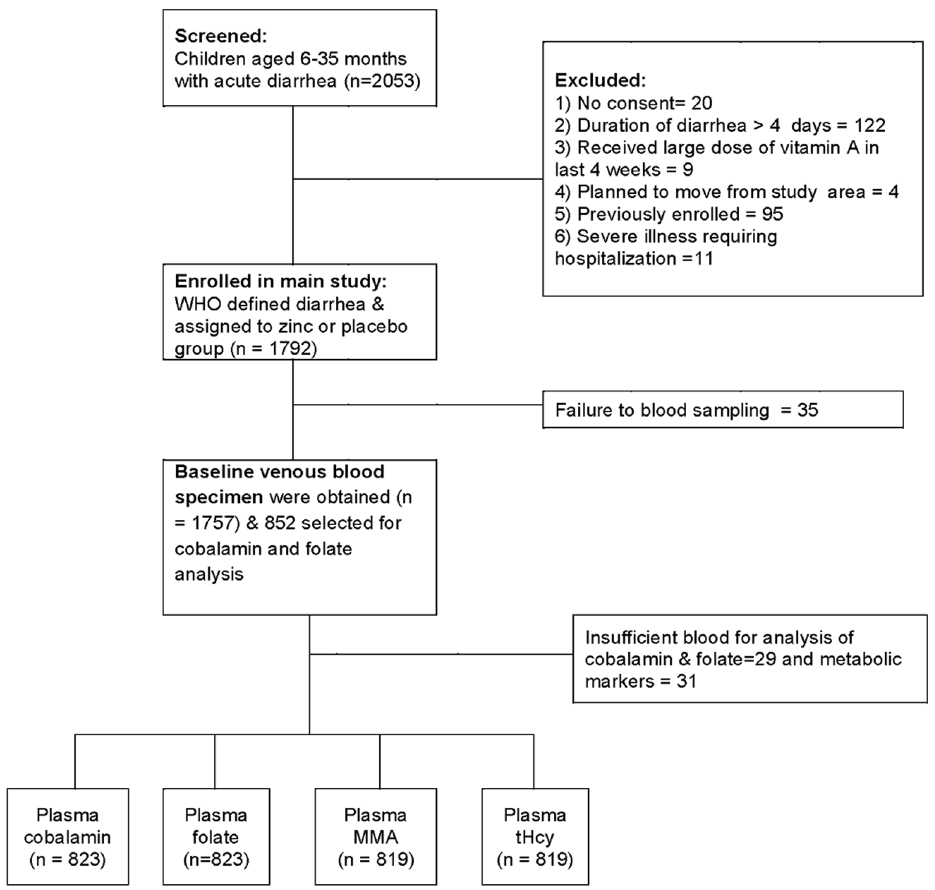
Figure 1. Flow chart of recruitment of children, blood sampling and analysis.